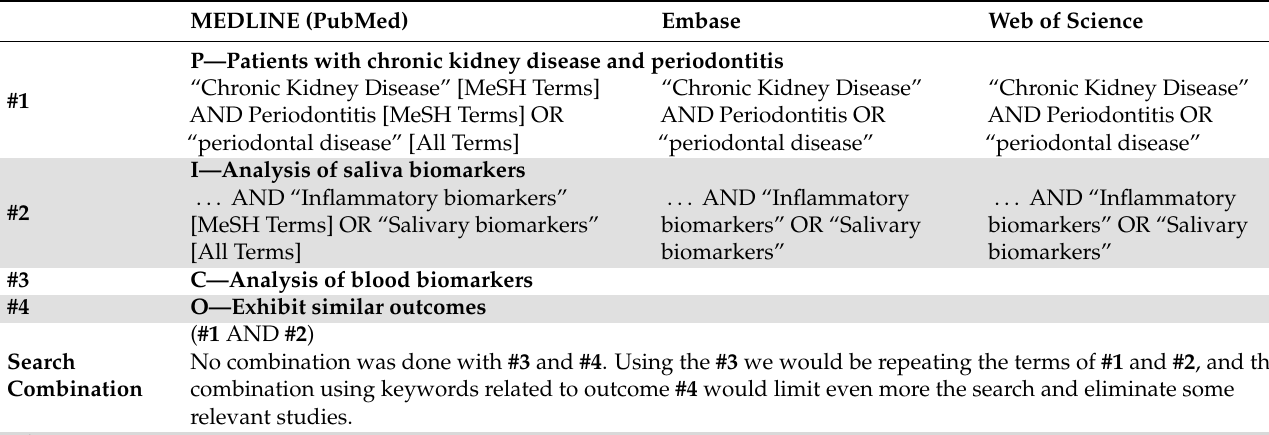
Table 1. Search strategy carried out and filters